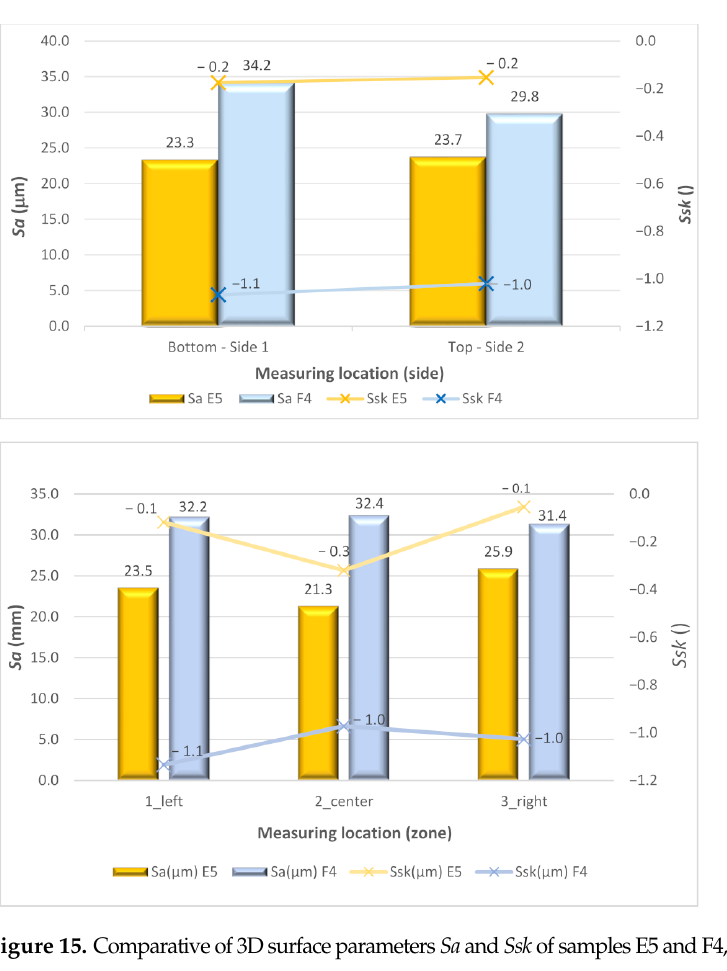
Figure 15. Comparative of 3D surface parameters Sa and Ssk of samples E5 and F4, versus Measuring location.